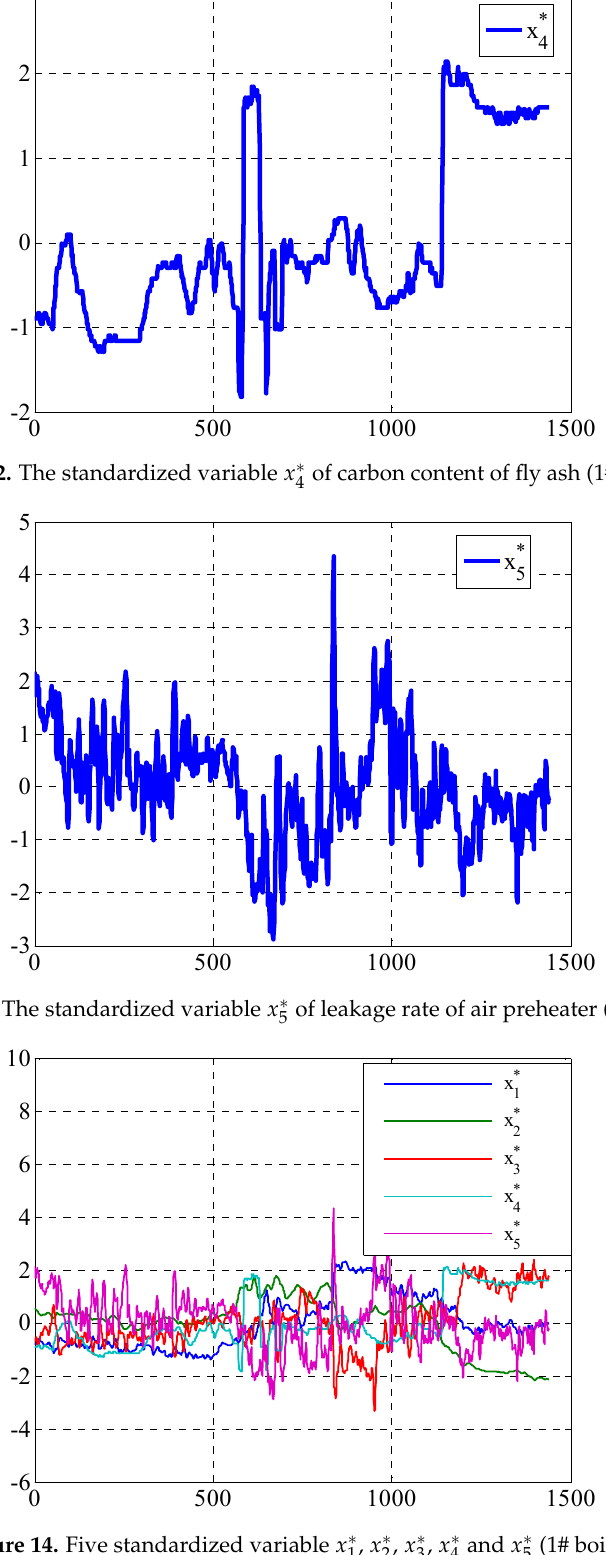
, x ∗ , x ∗ , x ∗ and x ∗ (1# 2 3 5 1 4